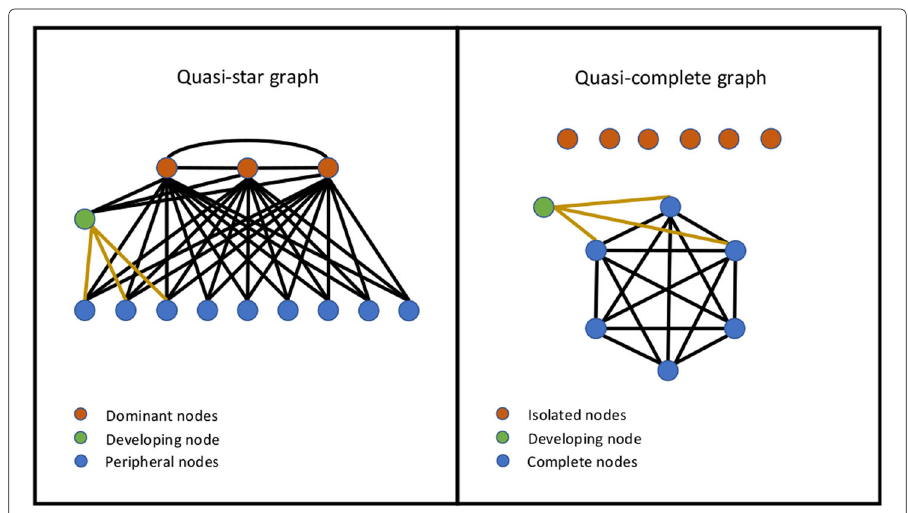
Fig. 1 Illustration of a quasi-star graph, left, and a quasi-complete graph, right. The golden edges refer to the edges making up the remainders in the graph construction process for a specified